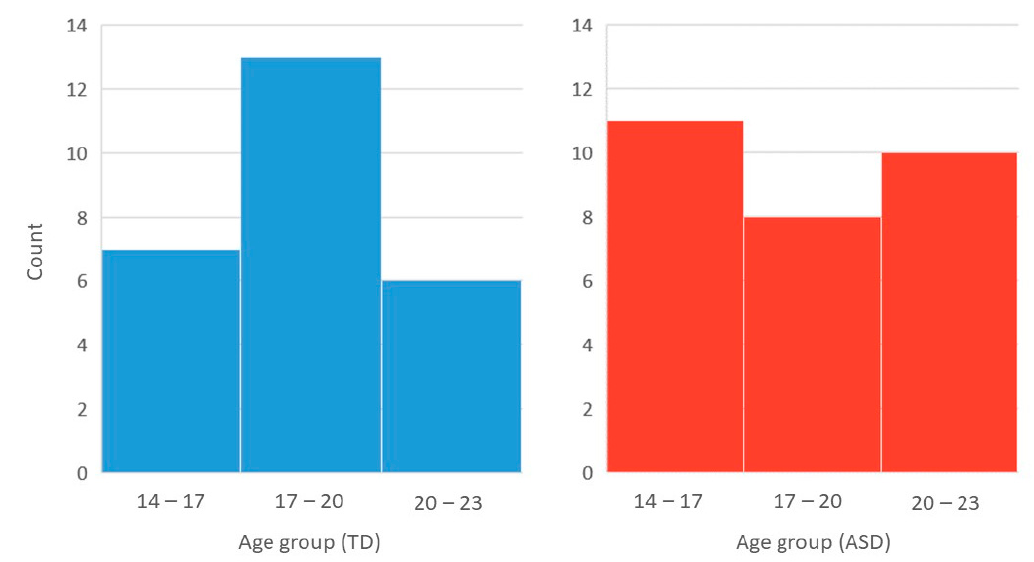
Figure 4. Histograms showing the age distributions of the TD ( left ) and ASD ( right ) group.